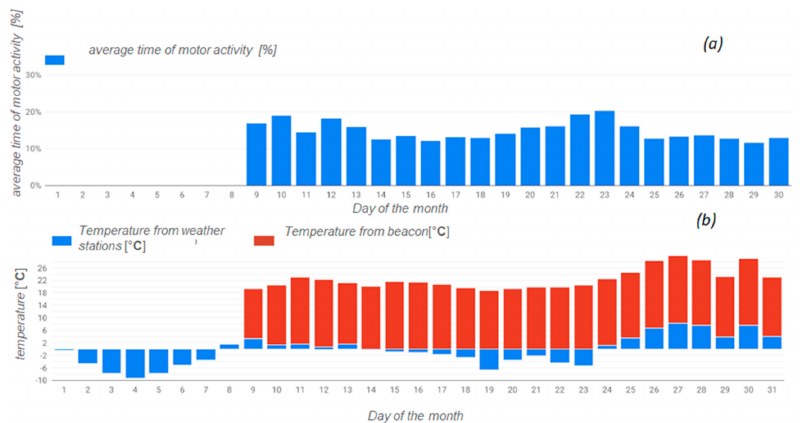
Figure 7. Daily activity in winter and temperature taken by weather station: ( a ) average time of motor activity and ( b ) temperature from weather stations, temperature from